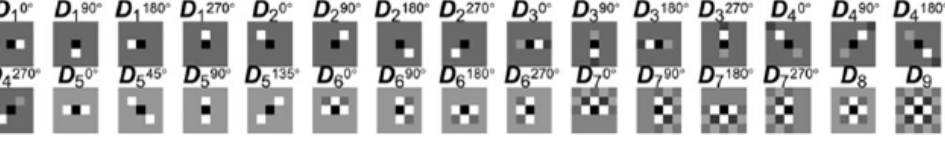
Figure 3. Thirty linear and nonlinear 5 × 5 SRM filters [19]. The filters are padded with zeros to obtain a unified size of 5 ×